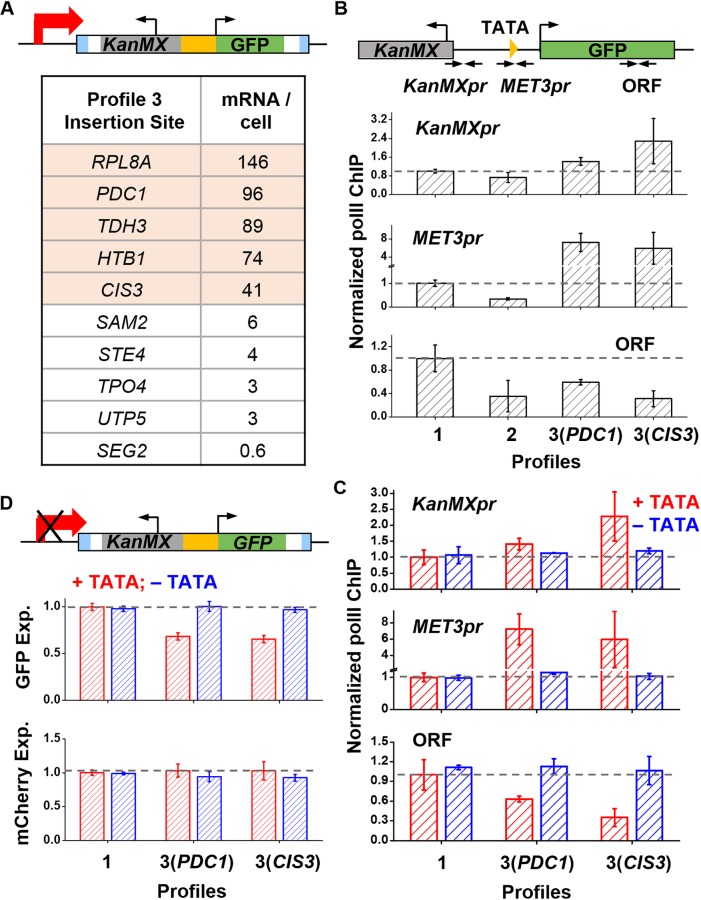
Repression in some profile 3 strains is due to transcriptional interference.A) Reporter insertion sites in profile 3 strains and the transcript levels of the local genes. Half of the profile 3 sites are located inside highly transcribed genes (highlighted in pink). B) Pol II ChIP over the KanMX promoter, MET3pr, and the GFP ORFs in four strains from profile 1, 2 and 3. The reporter cassette in the two profile 3 strains are located in PDC1 and CIS3, two highly expressed genes. All ChIP signals were normalized by that in the profile 1 strains. The error bars represent the standard errors among three biological replicates. High pol II density over the promoters in profile 3 strains were detected. C) Effect of the upstream TATA deletion on pol II density. The reporter cassette are located in either SNT2 (profile 1), or PDC1 / CIS3 (profile 3). Pol II ChIP signal was probed in identical locations as in (B). Deletion of the TATA box had no effect on pol II density over all three regions in the profile 1 strain (first two bars). In contrast, it restores the pol II density to the normal level in the two profile 3 strains. D) Effect of the upstream TATA deletion on GFP expression. Deletion of the PDC1 or CIS3 TATA box has no effect on mCherry expression, but restores the GFP expression to the same level as in the profile 1 strain.